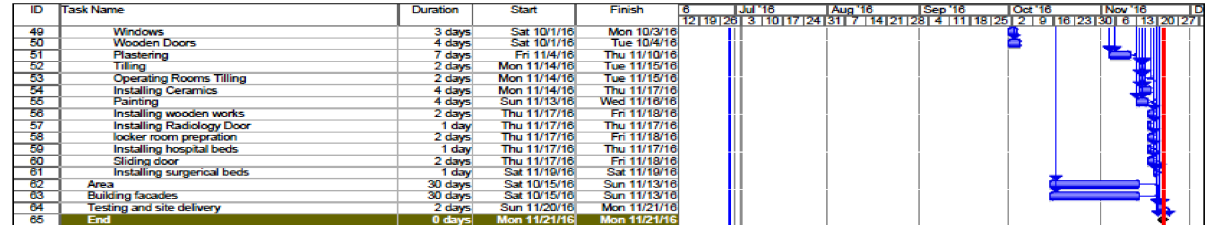
Figure 62. Gantt Chart of MSP 2010 for case study